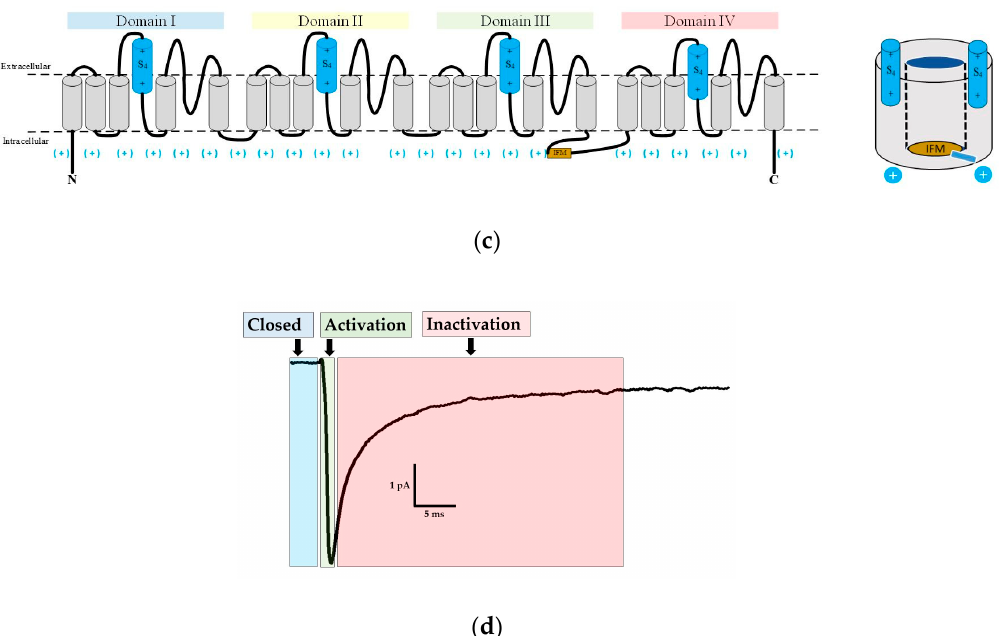
Figure 1. Schematic representation of gating. The three schemes of eukaryotic Na v s show the ( a ) closed; ( b ) open; and ( c ) inactivated gating states. ( d ) A typical membrane current of Rattus norvegicus of the Na v α 1.4 isoform responds to a depolarizing pulse reflecting the three main states of gating; IFM inactivation gate: brownish; S4 voltage sensors: sky blue.